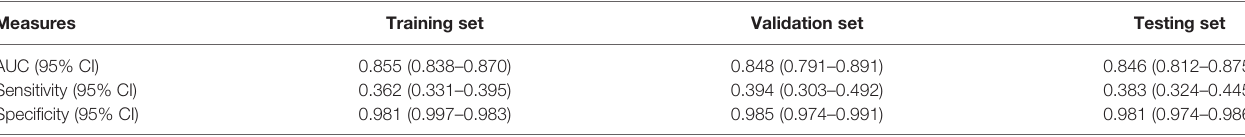
TABLE 5 | Performance of Model